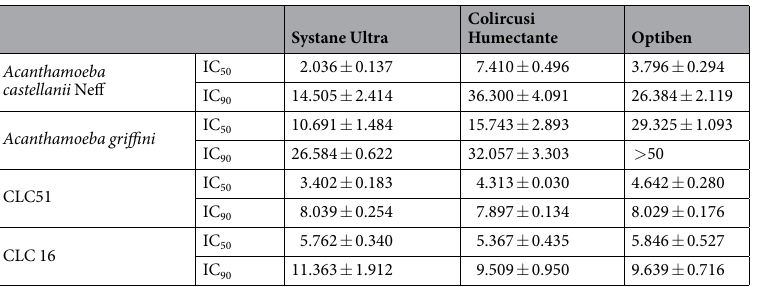
Table 3. Activity of Colircusi Humectante, Systane Ultra and Optiben against different strains of Acanthamoeba IC 50 (%) and IC 90